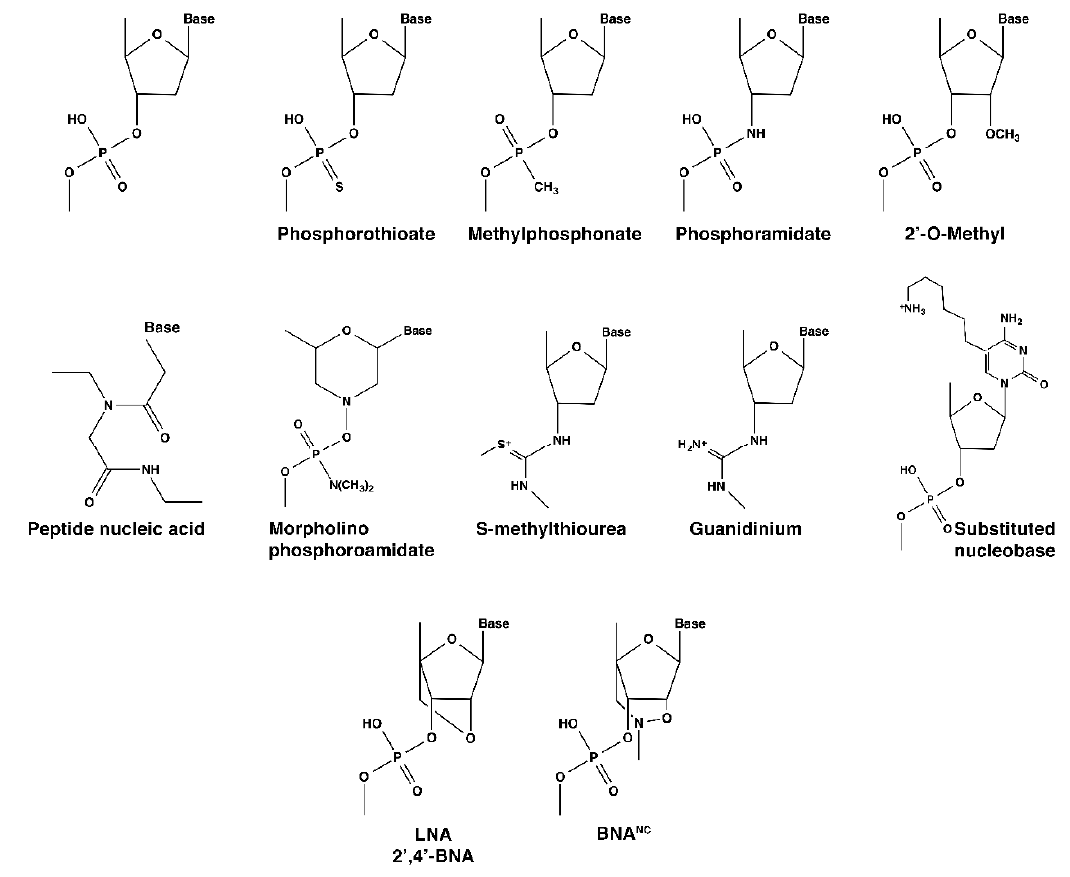
Figure 1. Chemical structures of nucleotide analogs.